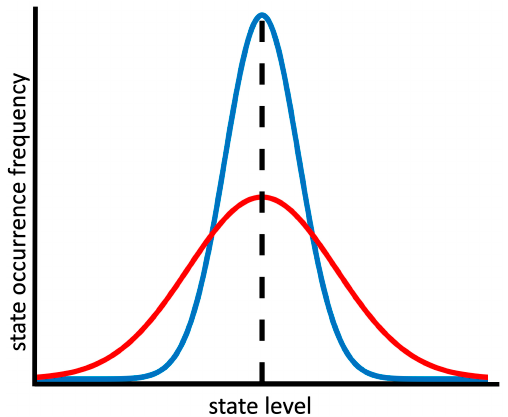
Figure 1. Personality state density distributions. The red and blue line describe the state density distributions corresponding to a personality trait of two individuals (cf. state extraversion of Red and Blue in the example given in the text). The dashed line specifies the mean shared by both distributions.